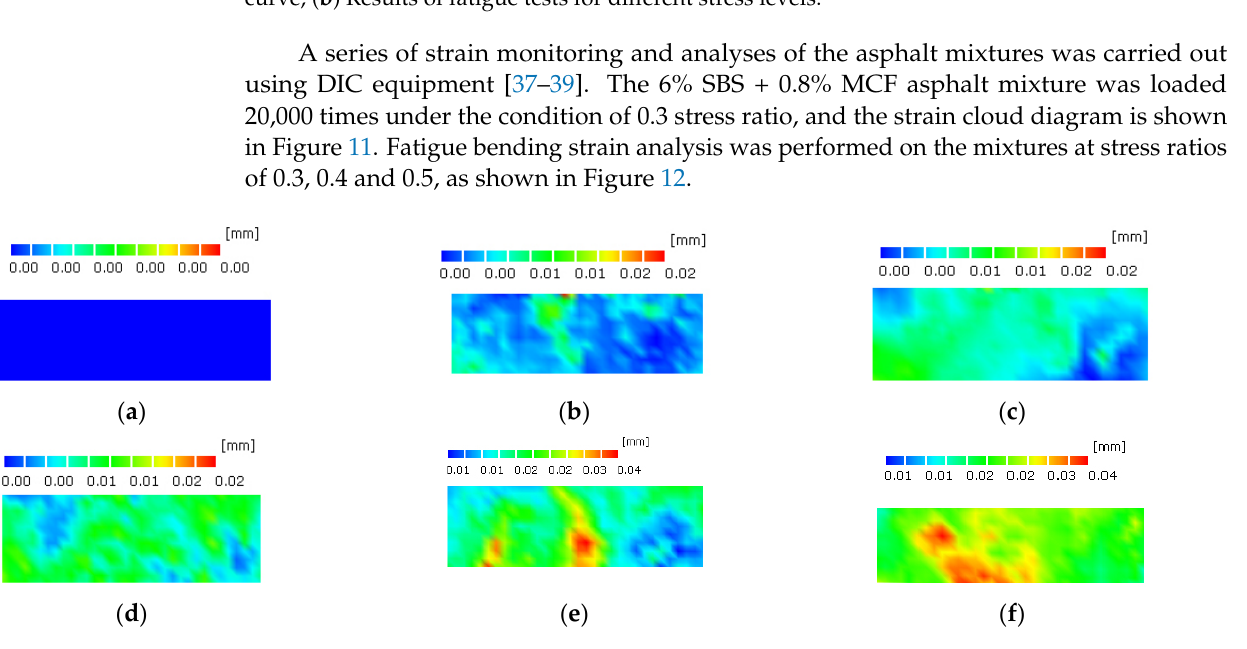
Figure 10. Bending stress-deflection curves and fatigue test results: ( a ) Bending stress- deflection curve; ( b ) Results of fatigue tests for different stress levels.